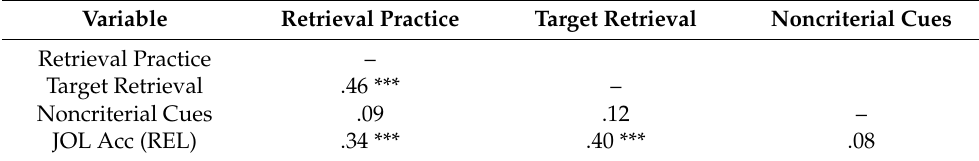
Table 10. Mean utilization and diagnosticity of target retrieval and noncriterial cues.